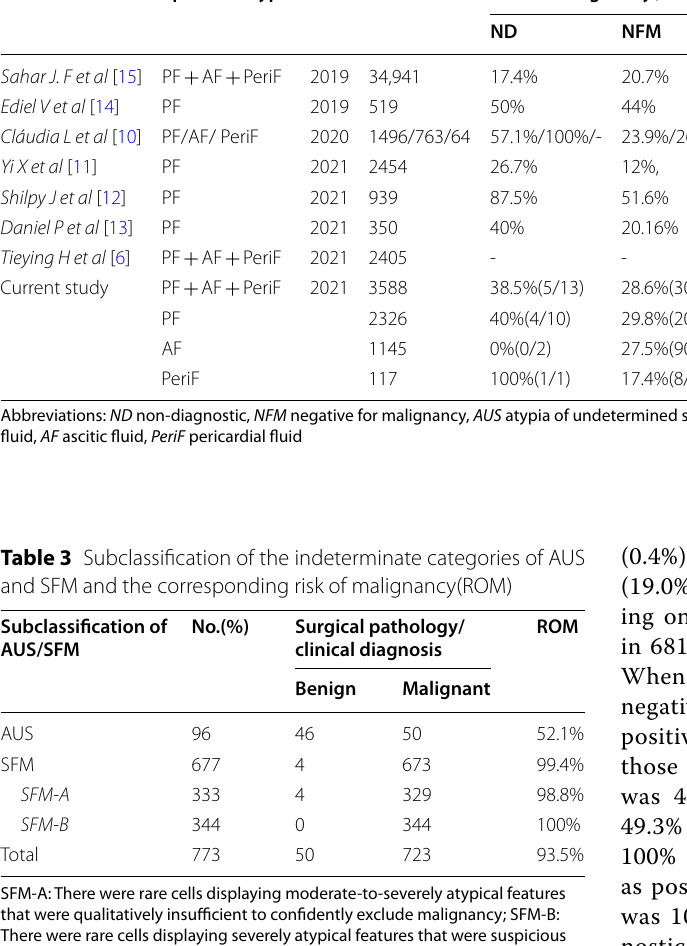
Table 2 The risk of malignancy in current study and comparison with a few previous publications